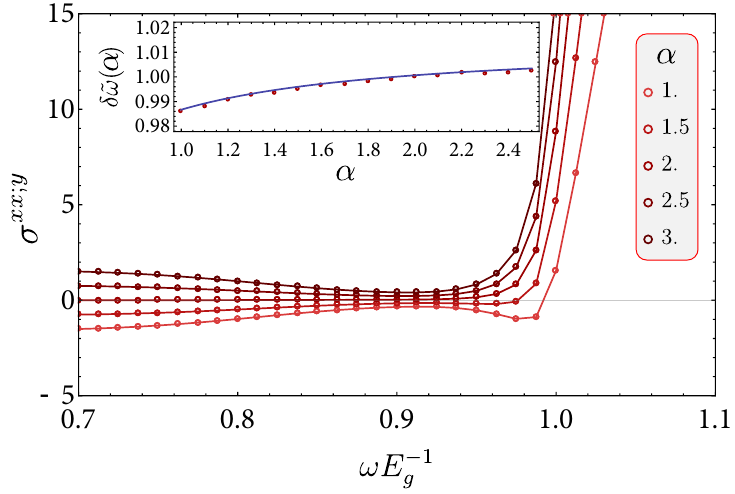
Figure 3: Dependence of the total conductivity σ ab ; c and the position of the onset of semiclassics as a function of the lifetime ratio α . The chemical potential is in the gap, throughout. Total conductivity for different values of the ratio α . For α < 2, the conductivity flips when crossing below the gap. Inset: δω normalized to the value at α = 2. The empty circles denote the numerically precise value showing the onset of semiclassics. The blue line is Eq. (28). The typically adopted α = 1 results in an onset of semiclassics earlier, that is closer to the gap, than at α =